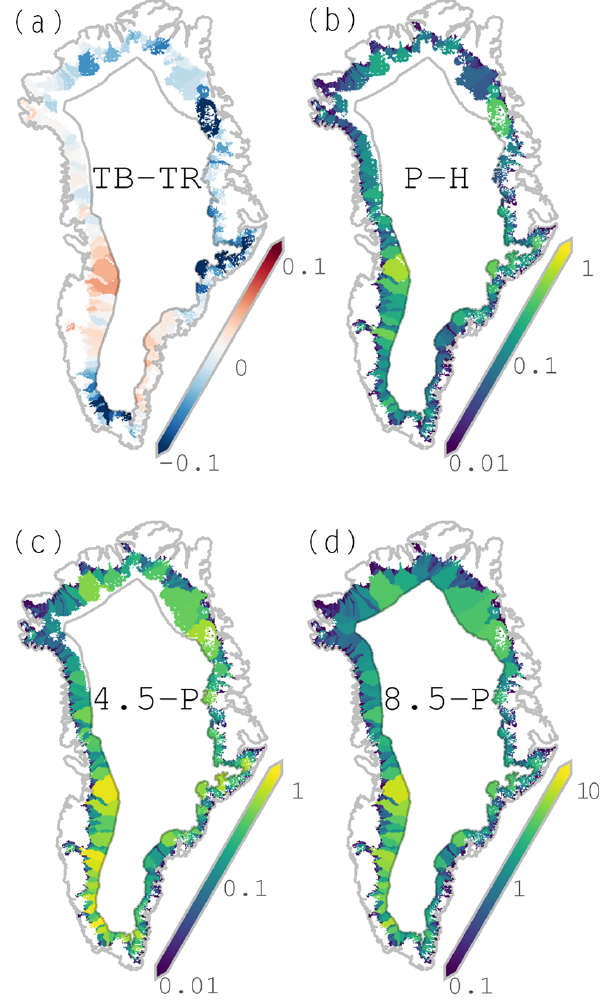
Figure 4. Change in GW (10 9 W) VHD per basin. Label TB-TR represents increase from reference to baseline periods (1985–1994 and 2007–2014) from Tedstone et al. (2015), P–H increase from historical to present, 4.5-P increase from present to 2090s under RCP4.5, and similarly for 8.5-P. Gray contours are 0 and 2000m el- evation. Tedstone et al. (2015) study region highlighted with black contour line in Fig. 5, right panel. Scale is linear for TB-TR, loga- rithmic for all others, and ranges differ.